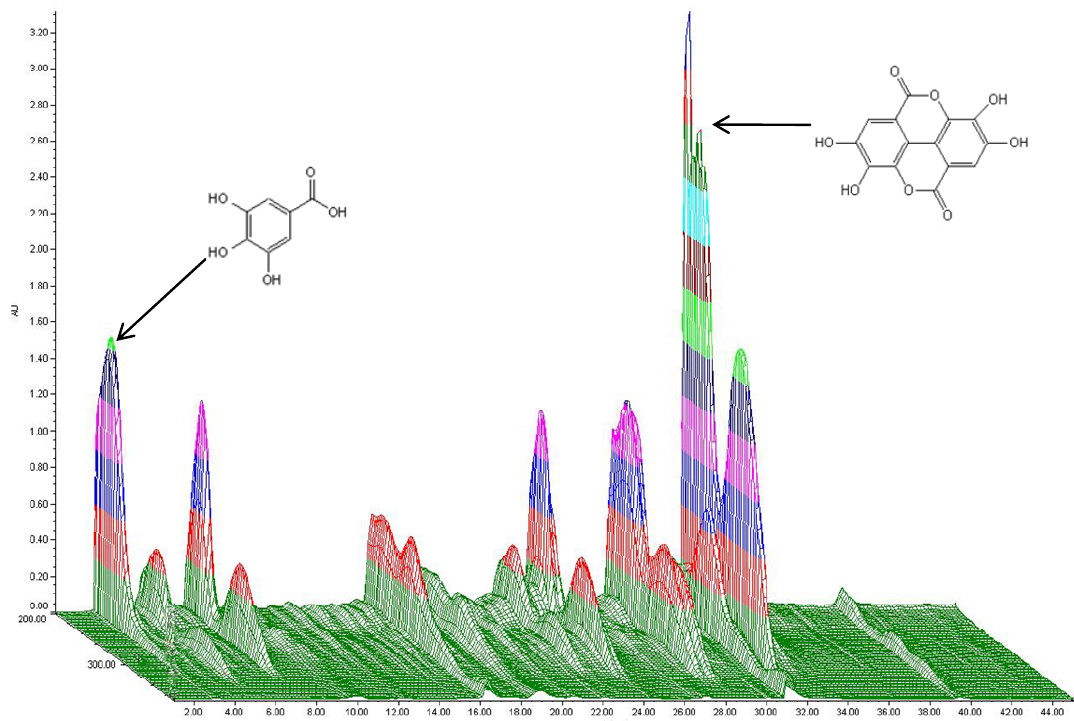
Figure 1. 3D HPLC spectrum of T. chebula extract showing gallic acid and ellagic acid.